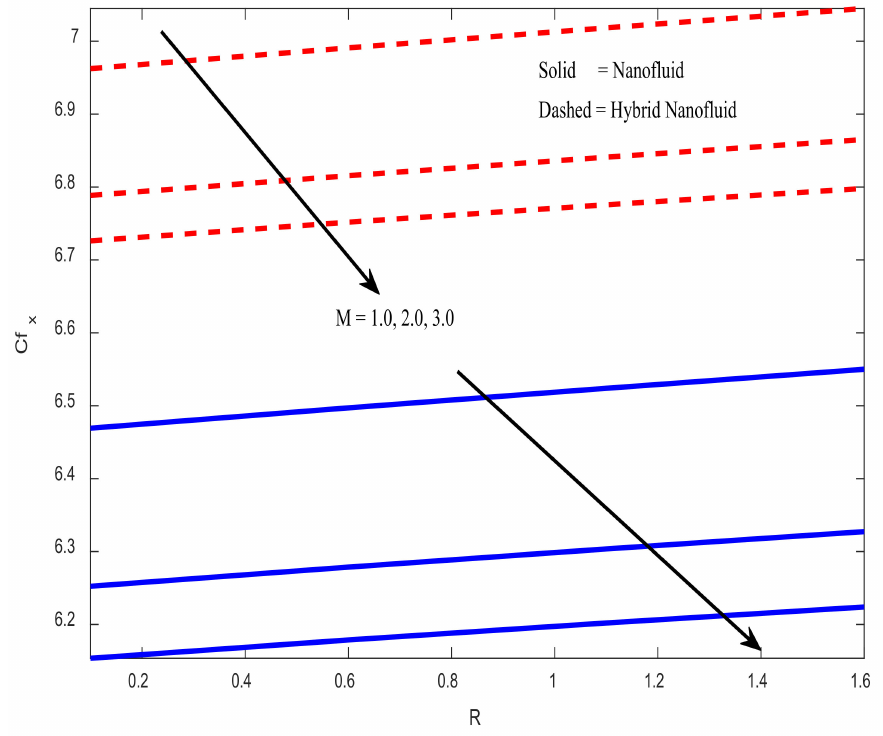
Figure 11. Influence of M on skin friction coefficient near the lower